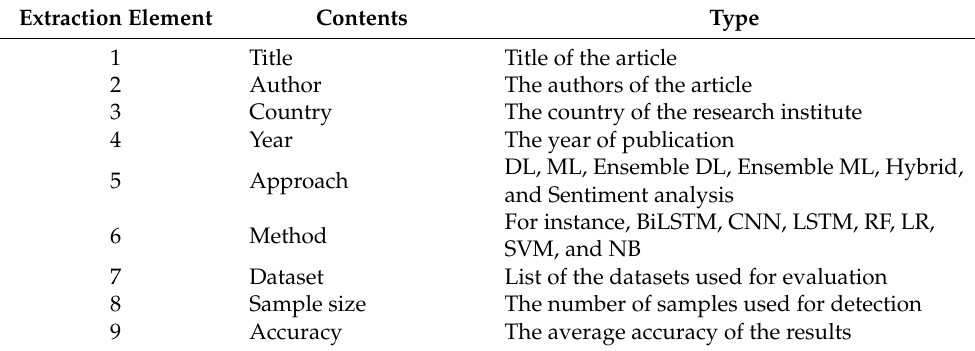
Table 2. Fields created to extract the relevant information for the meta-analysis. Extraction